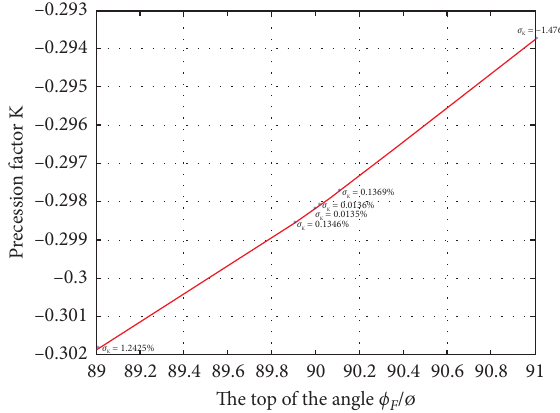
Figure 3: The relation between φ